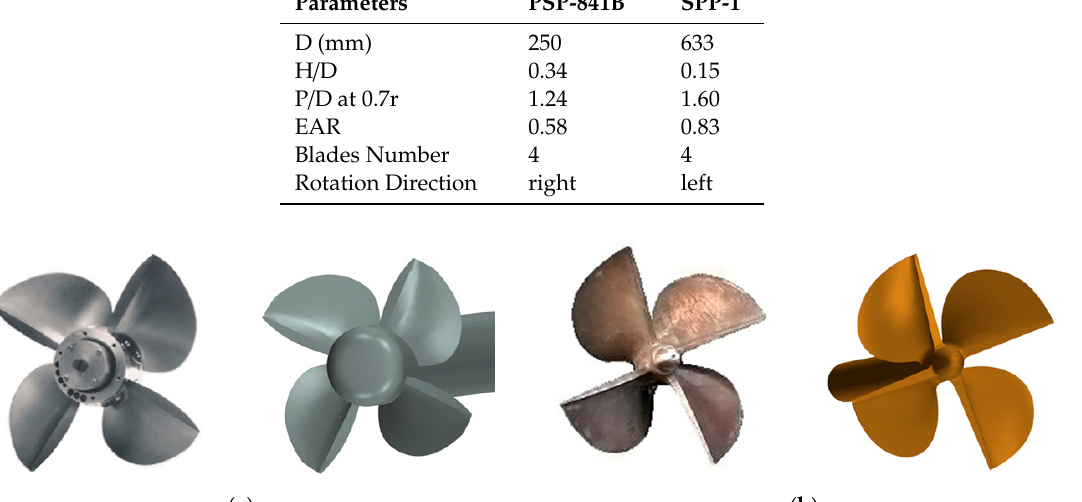
Figure 1. Three-dimensional view of modeling and actual propellers. ( a ) The 3D view of PSP-841B— left is the actual propeller and right is the 3D model; ( b ) the 3D view of SPP-1— left is the actual propeller and right is the 3D model.